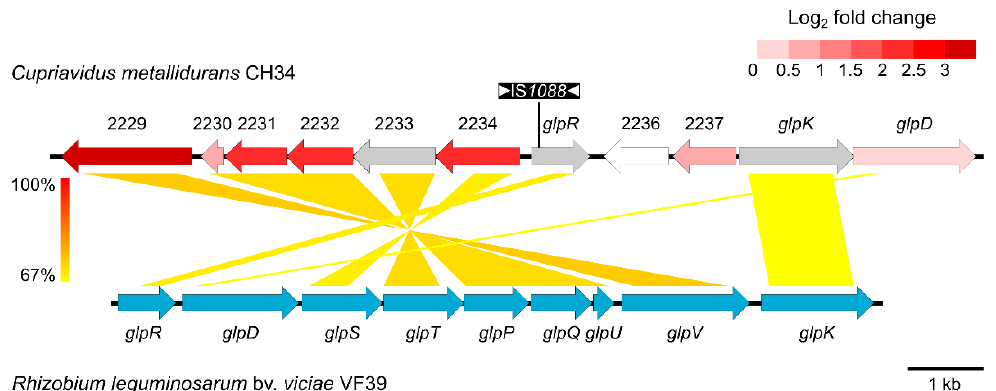
Figure 2. BLASTn comparison of the ABC-type transporter of C. metallidurans CH34/CH34 ZnR and the glycerol utilization cluster of the plasmid pRleVF39c from R. leguminosarum bv. viciae VF39 (accession no. JN390944). The colored shading indicates nucleotide identity between the sequences. Coding sequences (CDSs) of C. metallidurans CH34 are color-coded based on their log2 fold change (CH34 ZnR vs. CH34 expression), with grey being not detected. Insertion of IS 1088 in glpR of CH34 ZnR is shown.